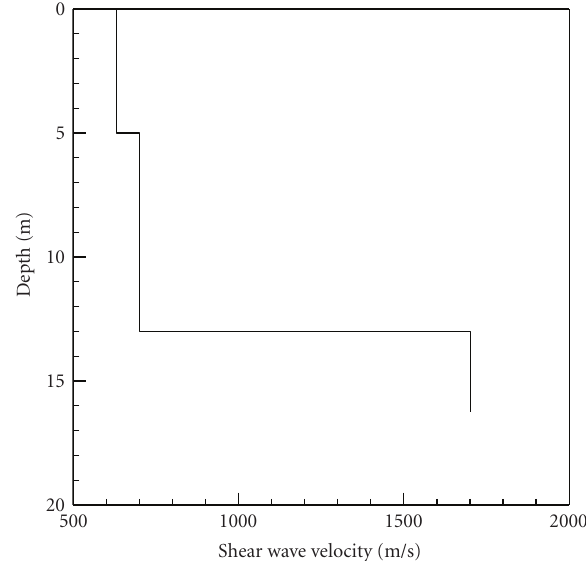
Figure 15: V s profile for Soccer Field of Carleton University based on the extracted dispersion curve and analytical generalized